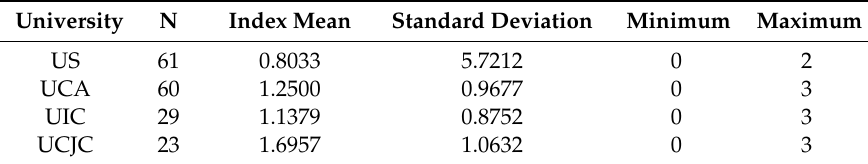
Table 9. Descriptive indices for pro-environmental attitude.